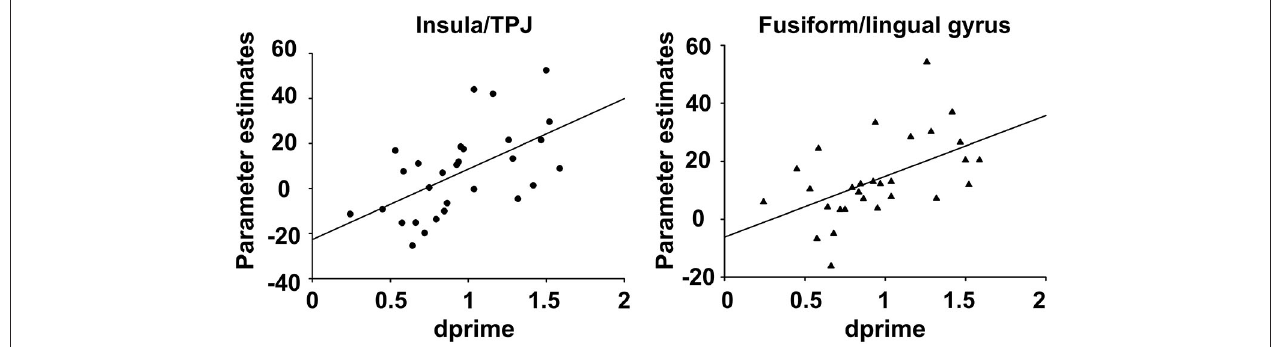
FIGURE 5 | Correlation between behavioral recognition performance and fMRI encoding activity. The figure depicts the correlation between behavioral recognition performance, as assessed with memory trace strength (d (cid:48) ), and fMRI activity, for the contrast (hits > misses) during the encoding phase of the subsequent memory task. For both clusters, increased activity for (hits > misses) was positively correlated to better recognition